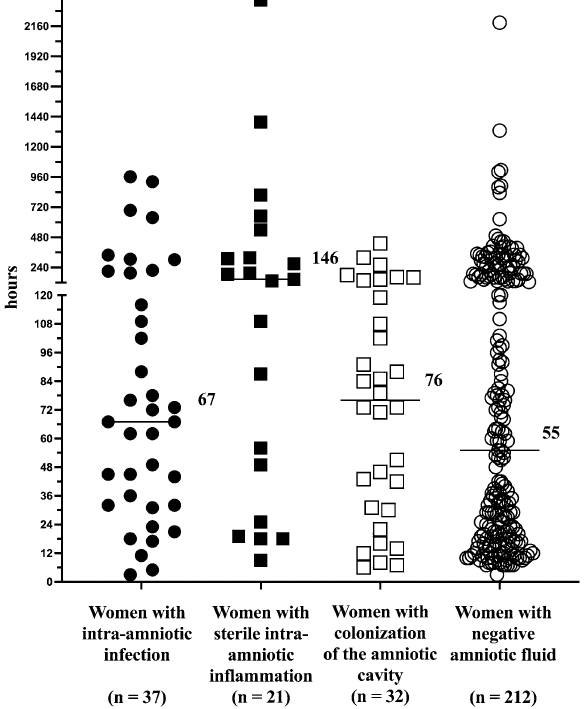
Figure 3. Latency interval (hours) from rupture of membranes to delivery in women with preterm prelabor rupture of membranes with respect to intra-amniotic infection, sterile intra-amniotic inflammation, colonization of the amniotic cavity, and negative amniotic fluid. The median values are